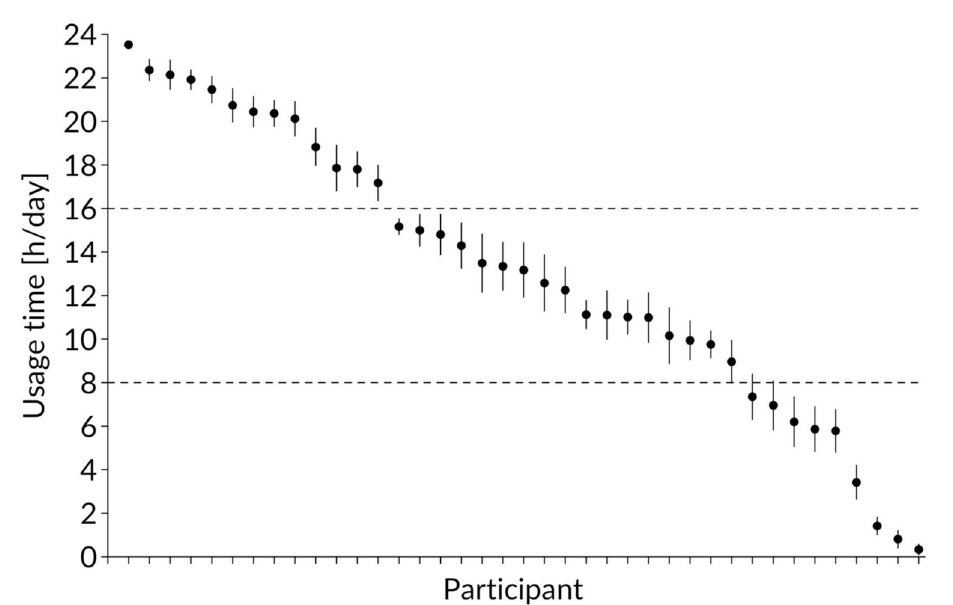
Figure 1. Average usage behavior in the 9-week period for all